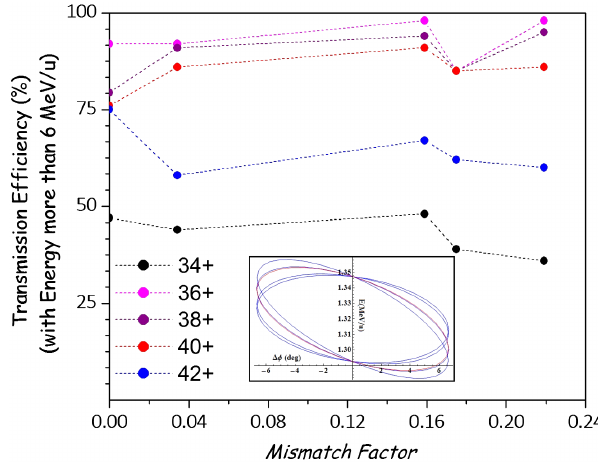
FIG. 7. Transmission efficiency with mismatch factor for different charge states. The inset shows the orientation of the mismatched ellipse (red showing the acceptance ellipse).